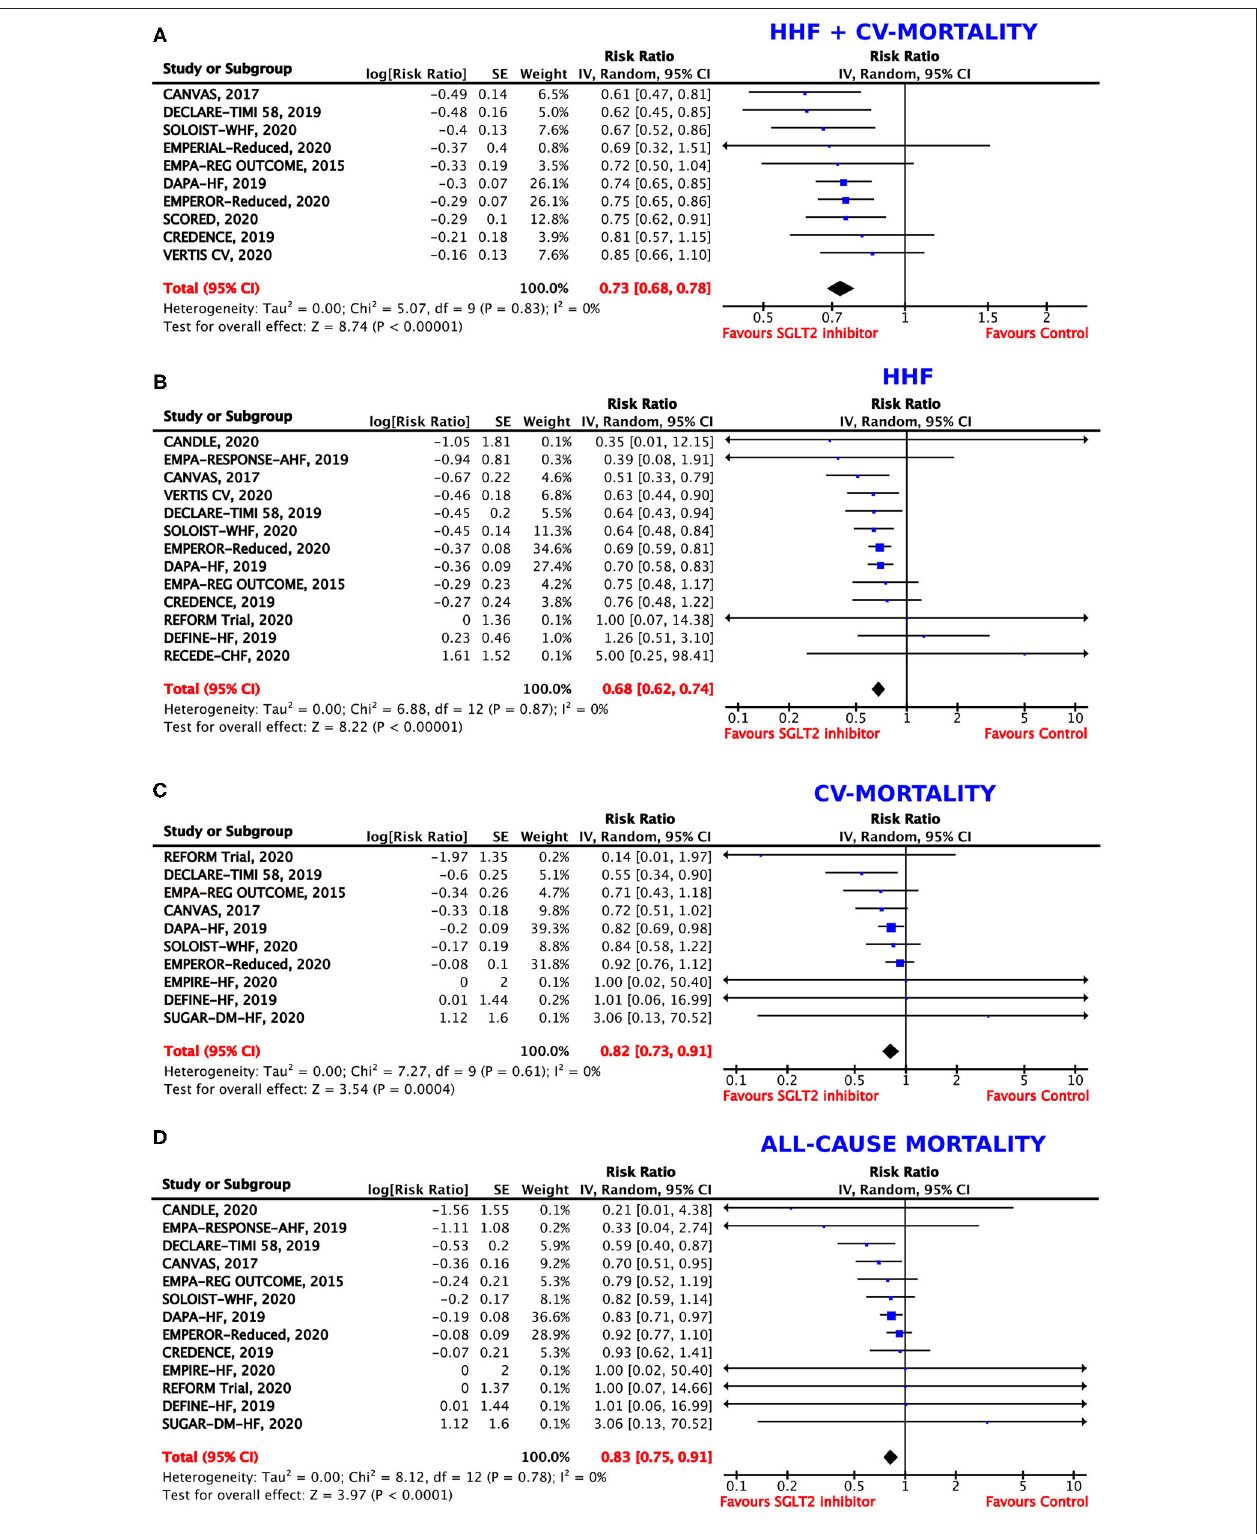
FIGURE 1 | Forest plot depicting the risk ratio for (A) the composite outcome of hospitalization for heart failure (HHF) or cardiovascular (CV) mortality, (B) HHF alone, (C) CV mortality alone, and (D) all-cause mortality.